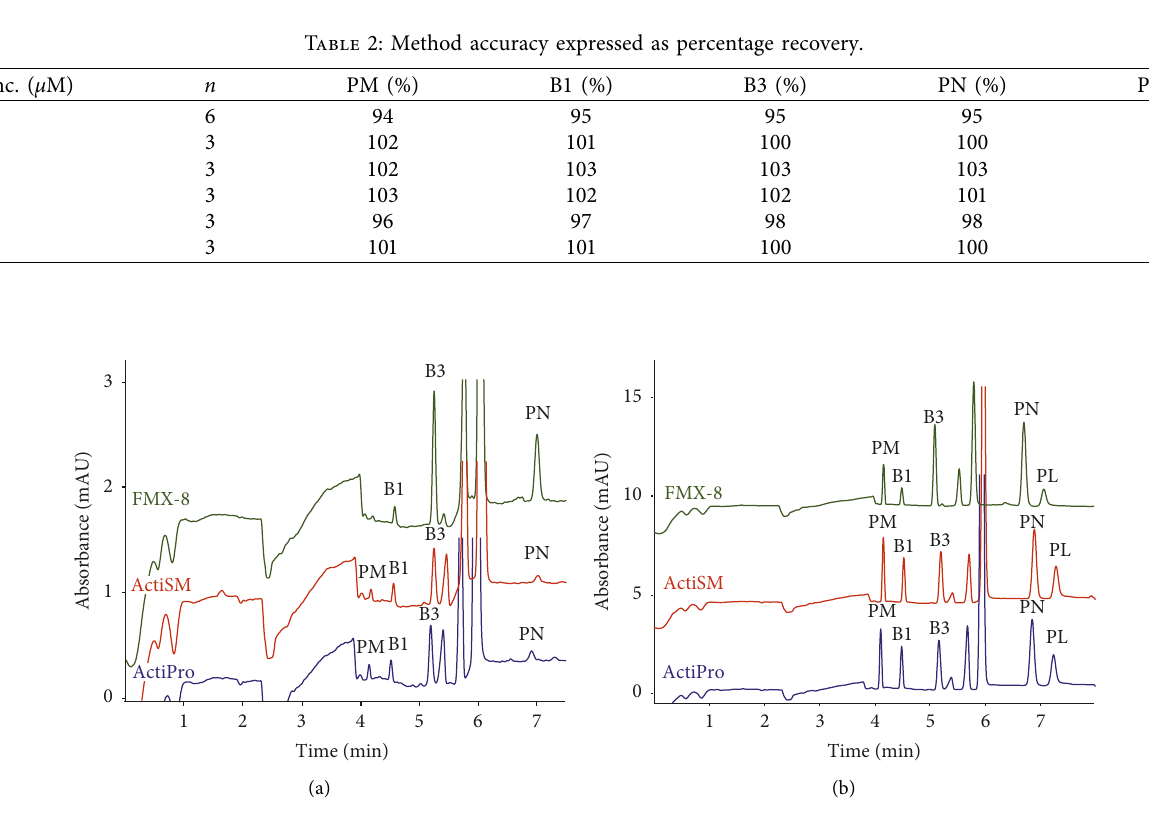
Figure 2: Electropherograms of (a) FMX-8 MOD, ActiSM, and ActiPro medium and (b) FMX-8 MOD, ActiSM, and ActiPro medium spiked with standard vitamins (50 µ M) analysed with BGE: 100mM phosphoric acid, 55mM T-EthA. Applied voltage 13 kV; resulting current 40–46 µ A. PM: pyridoxamine, B1: thiamine, B3: nicotinamide, PN: pyridoxine, PL: